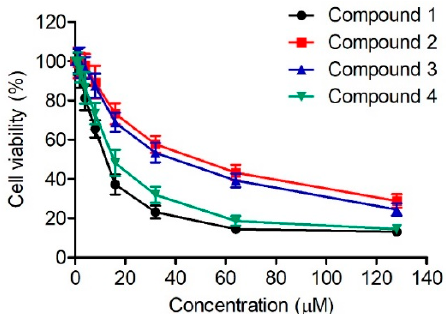
Figure 5. Inhibitory effects of four compounds on the proliferation of A549 cells. The results are representative of three independent experiments and are expressed as mean ± SD.